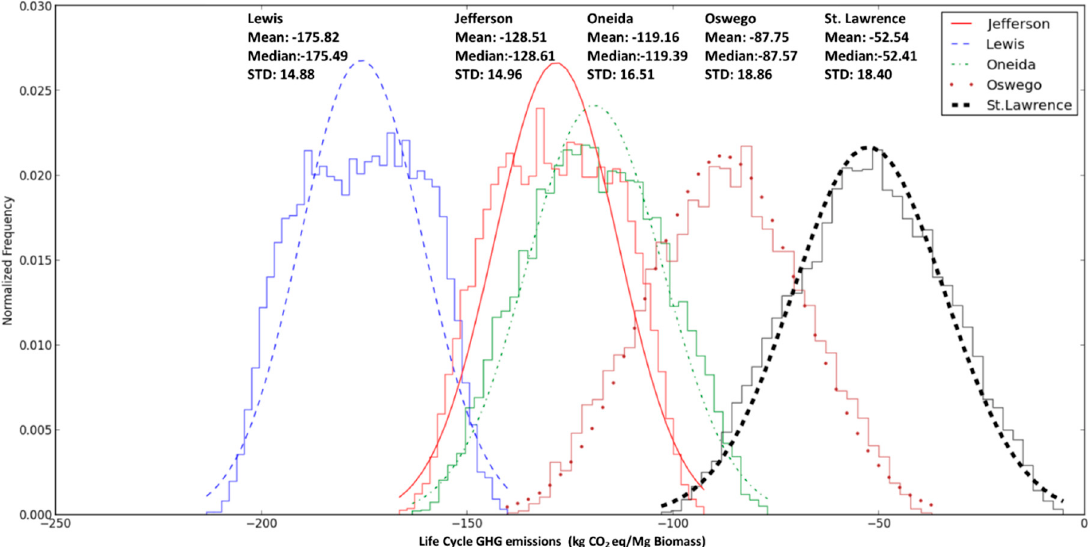
Figure 12. Monte Carlo uncertainty analysis for 30 cm soil depth for cropland/pasture in five counties. Contour step lines are the actual distributions of life cycle GHG emissions from 10,000 simulations. Bell shape lines represent normal distribution with same mean and standard deviation as the distributions. Mean and standard deviation of Monte Carlo analysis are listed above bell shape line of each county.